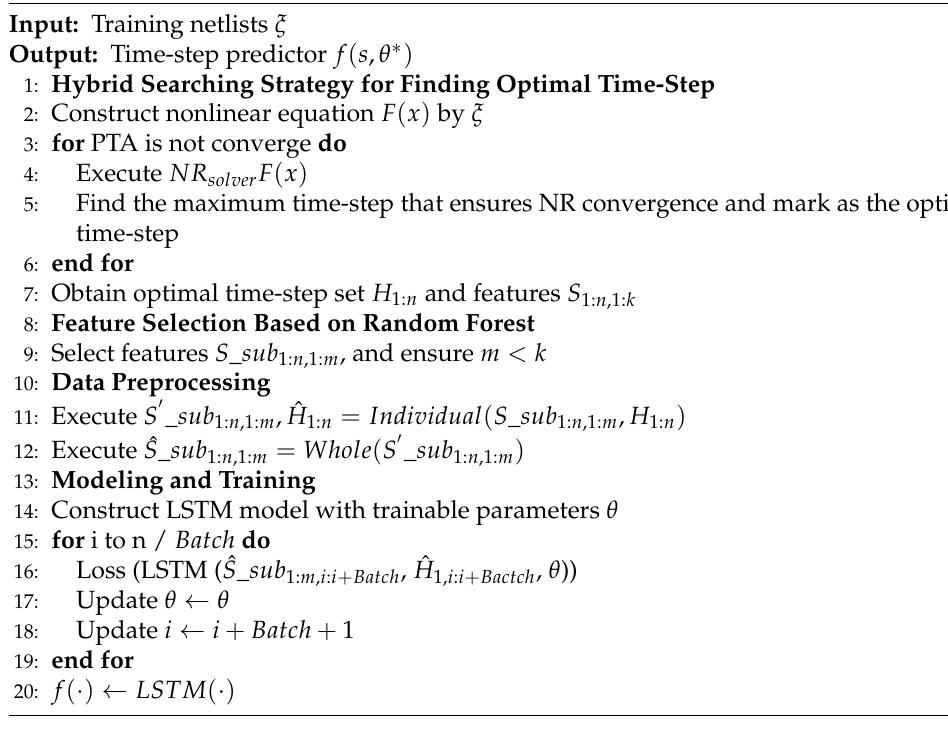
Algorithm 1 LSTM-enhanced time-step control method for